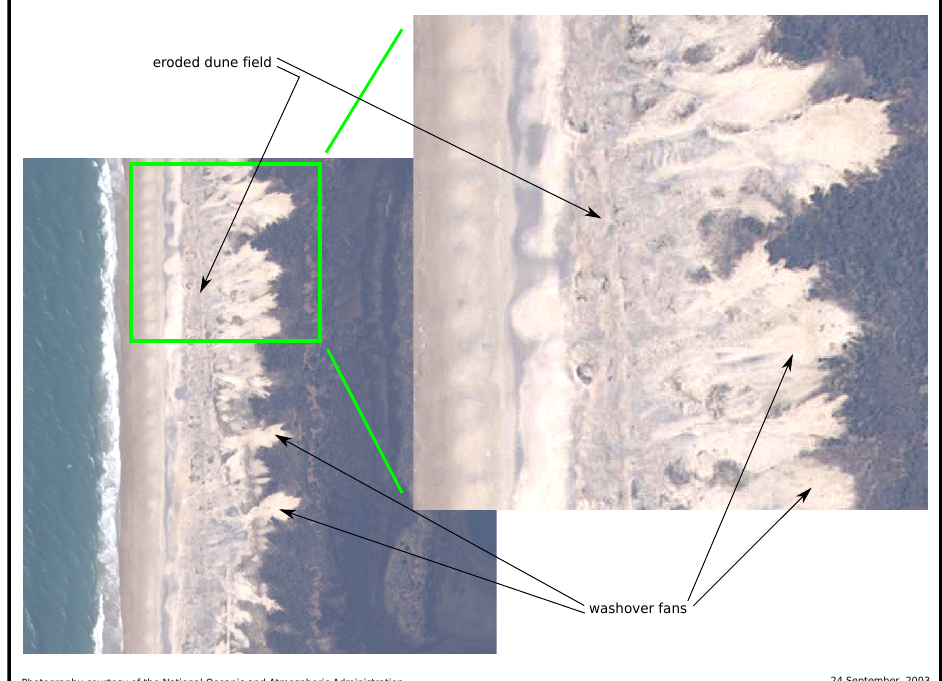
Figure 8. Aerial view of a section of the beach, dune field and island interior along Core Banks. The photograph was captured immediately following the hurricane’s passage in September 2003. Isabel made landfall along Ocracoke Island, some 30 km to the north of the present study site. The image clearly shows the scoured beach and dune field and the recipient of a large fraction of the eroded material, the numerous washover features draped across the island’s